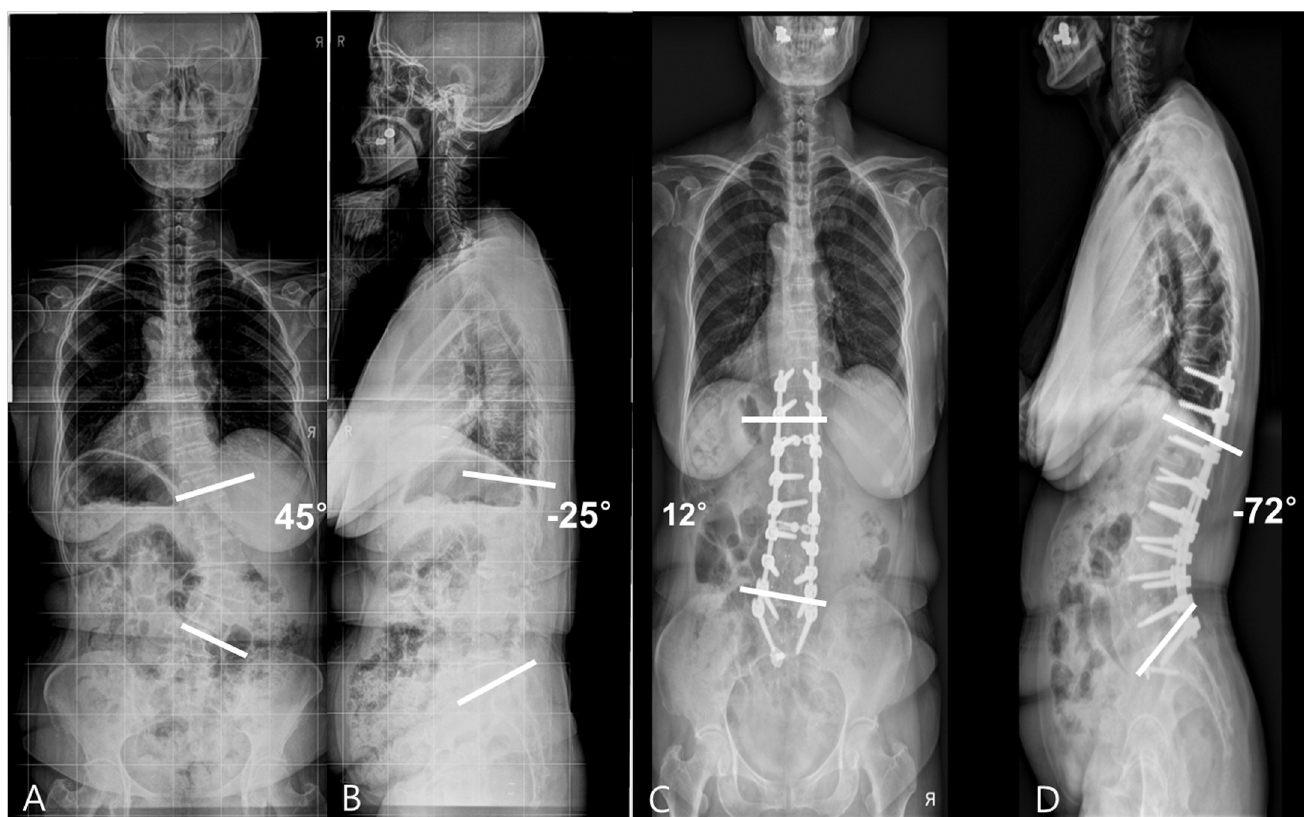
Fig 1. (A, B) Anteroposterior (AP) and lateral standing radiographs of a 65–year–old woman with severe back pain and pain in both legs, showing degenerative lumbar kyphoscoliosis. A three–step (posterior–anterior–posterior) approach was used to obtain adequate sagittal and coronal balance. (C, D) Postoperative AP and lateral radiographs showed L3–S1 interbody fusion and good sagittal